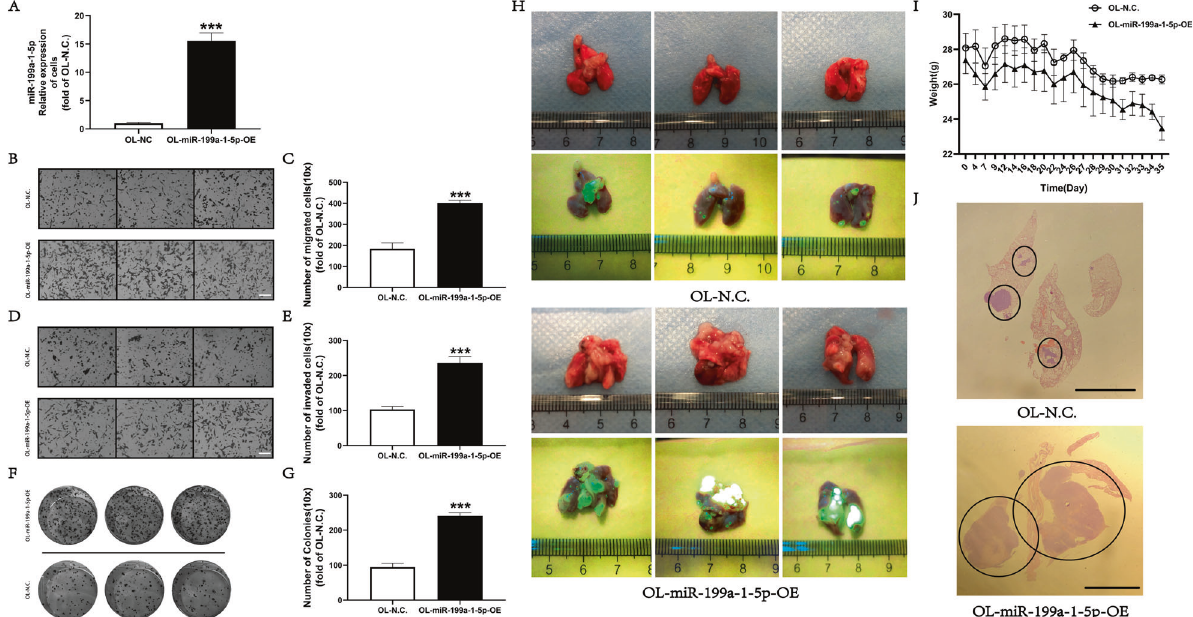
Fig. 3 Overexpression of miR-199a-1-5p expression effectively enhanced the metastatic colonization ability of OL in vitro and in vivo. A miR-199a-1-5p expression in OL-N.C. and OL-miR-199a-1-5p-OE evaluated by RT-qPCR. *** P < 0.001. Visualization ( B , bar = 60 μ m) and quantitative analysis of ( C , *** P < 0.001 ) the migration ability of OL-N.C. and OL-miR-199a-1-5p-OE cells. Visualization ( D , bar = 60 μ m) and quantitative analysis of ( E , *** P < 0.001) of the invasive ability of OL-N.C. and OL-miR-199a-1-5p-OE Cells. Visualization ( F ) and quantitative analysis ( G , ***P < 0.001) of the clonogenic ability of OL-N.C. and OL-miR-199a-1-5p-OE cells. H Analysis of the effect of miR-199a-1-5p overexpression on metastatic colonization in vivo. I The weight changes of mouse injected with OL-N.C. and OL-miR-199a-1-5p-OE cells. J H&E staining of metastatic nodules in the lungs, bar = 5